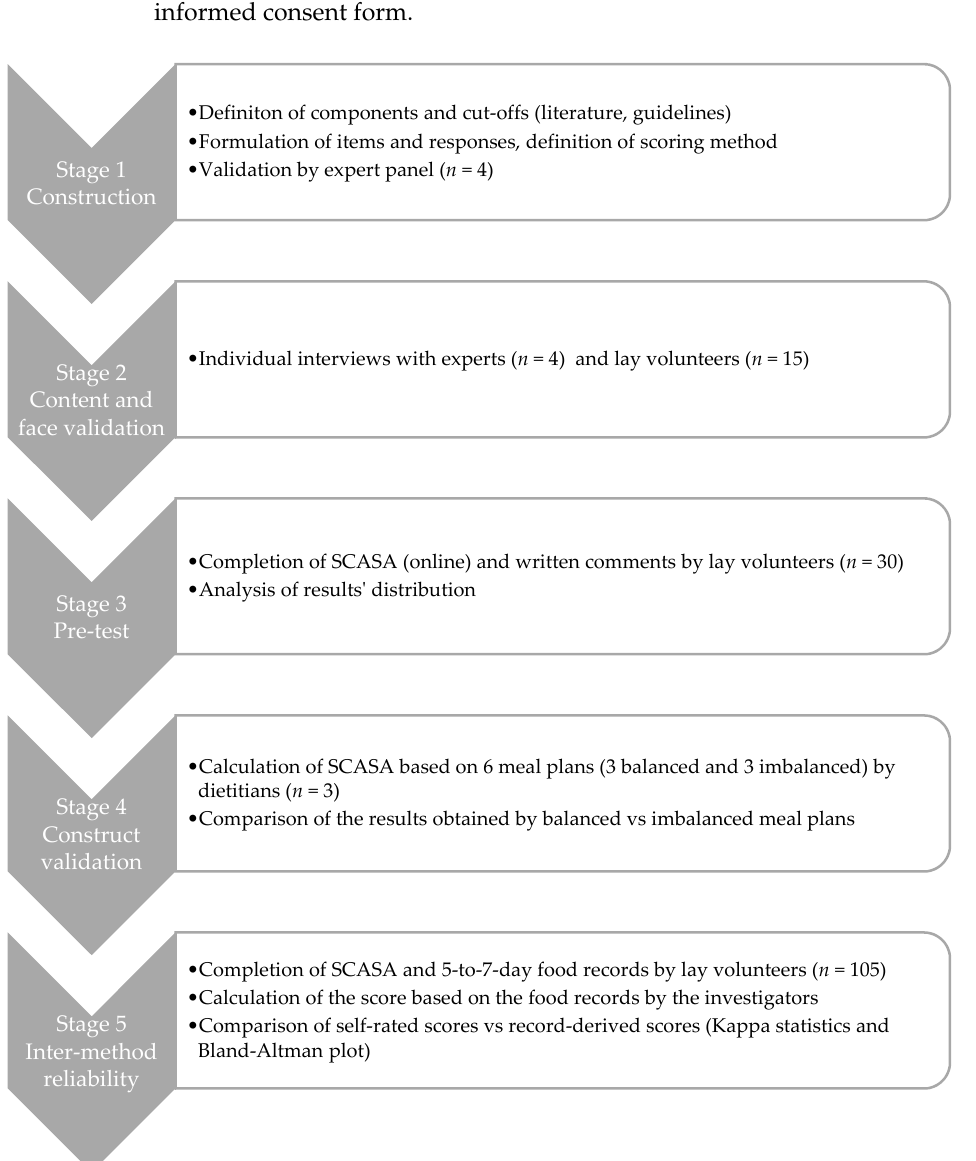
Figure 1. Overview of the development process of SCASA (Score d’Alimentation Saine).